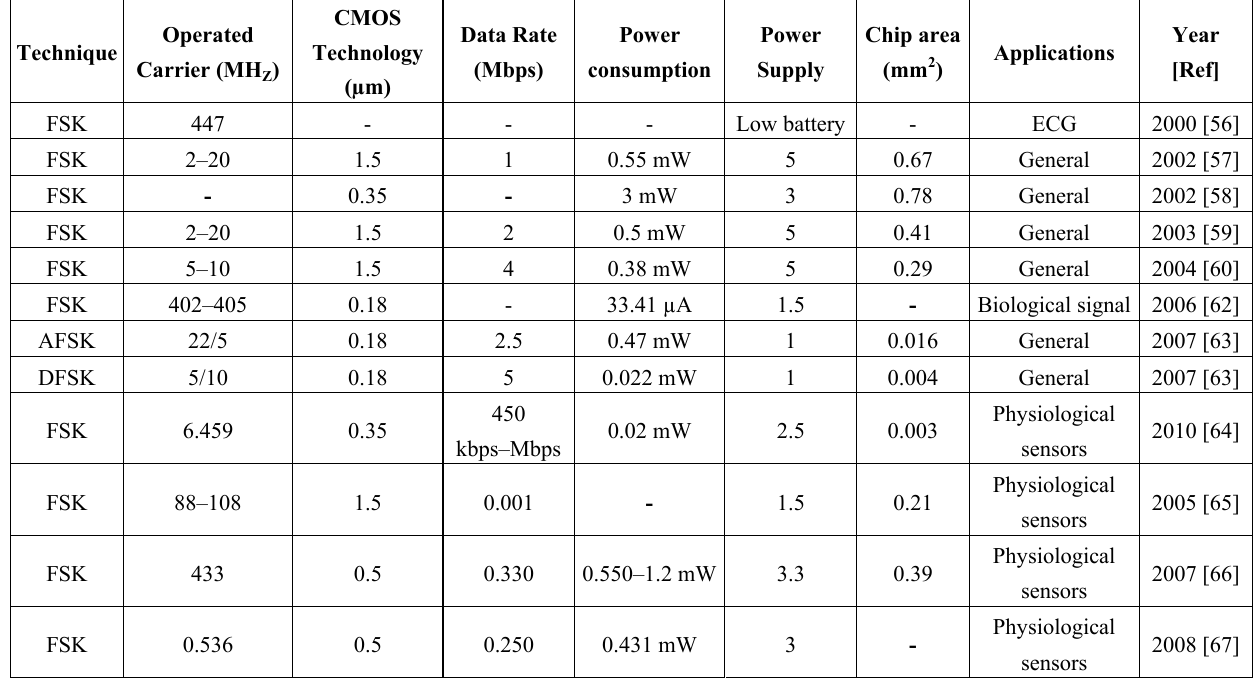
Table A2. FSK modulations used in telemetric wireless and implanted devices.